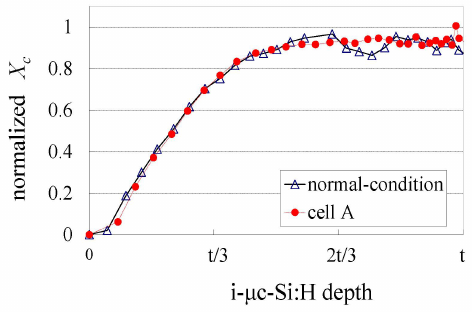
Figure 4. Results of Raman analysis of polished test cells; normal-condition cell and cell A. Values of X c were normalized by the maximum value of X c among normal-condition cell and cell A. X c was expressed from the TCO